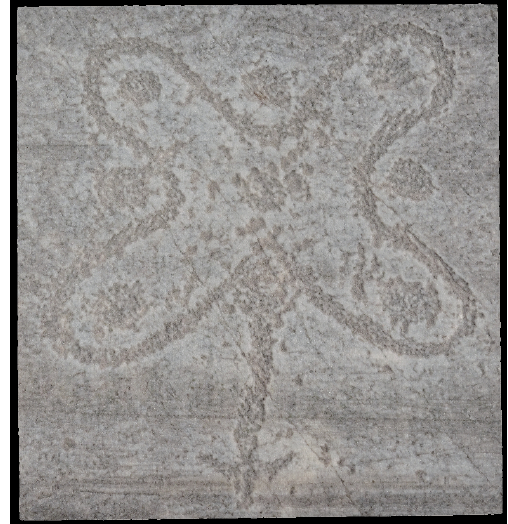
Figure 6: The figure shows a visualization of the ground truth mesh rose that has been printed in 3D and is used as one of our test objects for laboratory measurements. The size of the print is approximately 15 × 15 cm.